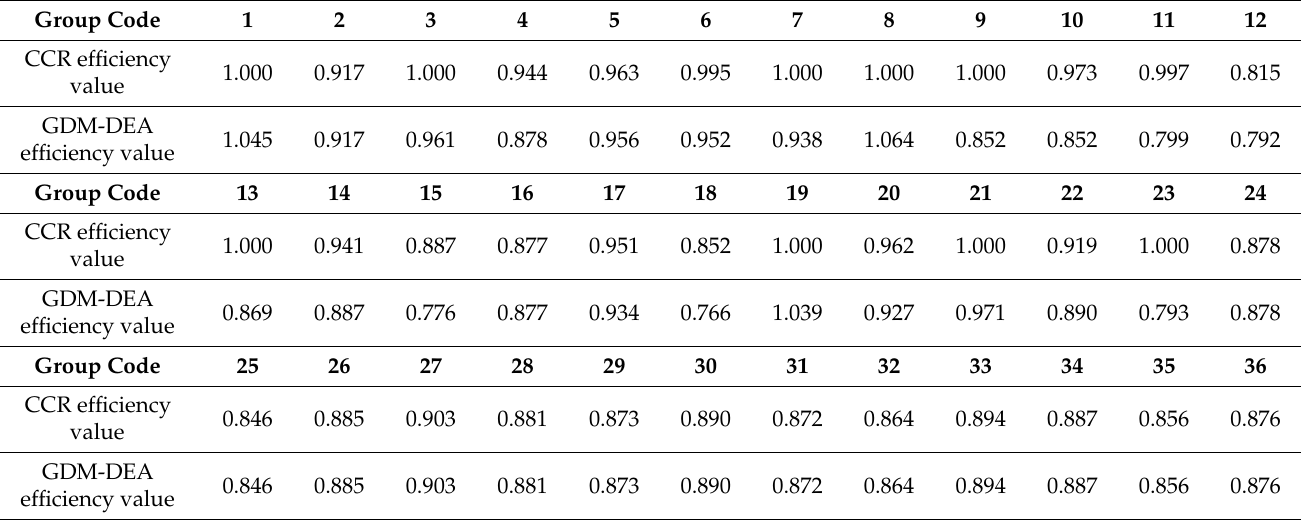
Table 3. GDM-DEA efficiency value of the JLASTU experiment cultivation